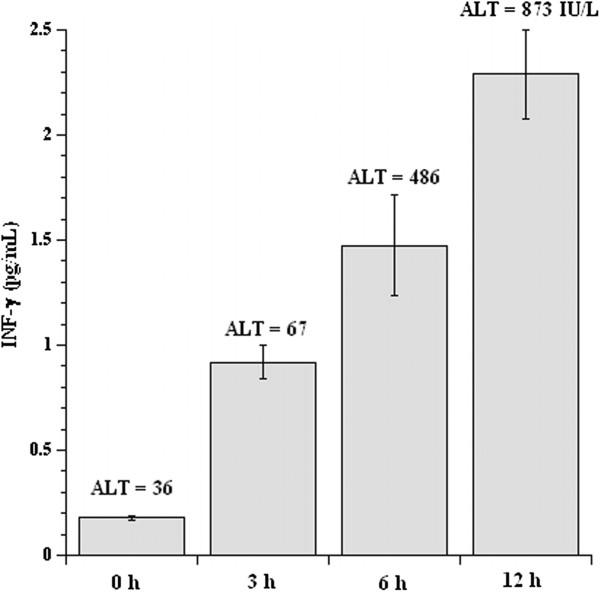
Serum IFN-γ and ALT in untreated and ConA-treated C57Bl/6 mice. C57BL/6 mice were injected with PBS or 12 mg ConA/kg. Serum was collected 3, 6, and 12 hr post- injection and processed for IFN-γ. IFN-γ values shown are mean (± SD) of three determinations for each sample (n = 3 animals/sample). ALT activities at 0, 3, 6, and 12 hr are from a single experiment (see Results).